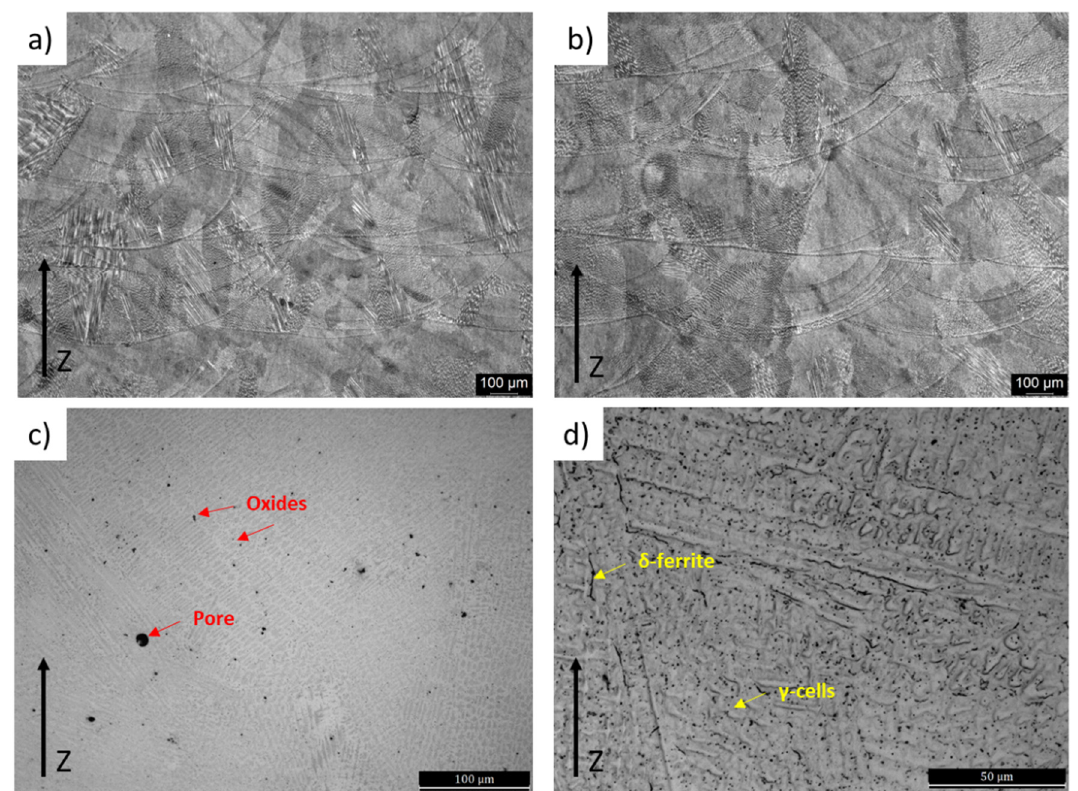
Figure 4. Optical micrographs of the X-Z cross-section of ( a ) LP and ( b – d ) HP sample. The samples are oriented along the building direction. ( c , d ) High magnification images show the defects and the cellular structure. Table 2. Data of cubes built with high power and low power parameters.